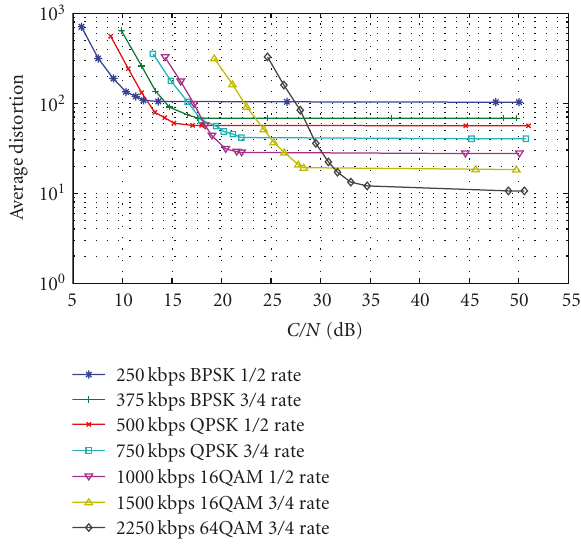
Figure 13: Optimum distortion-based link adaptation, coastguard , GOP number 21, Set (b).